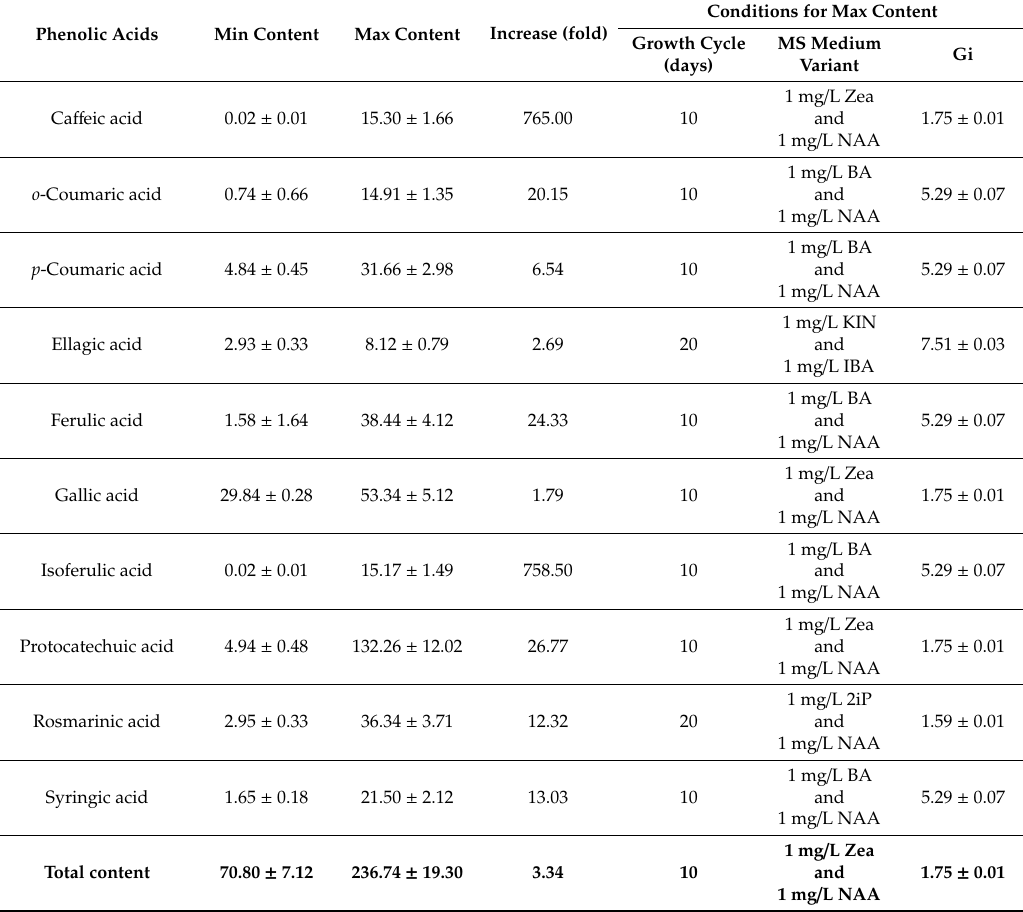
Table 3. The range of individual and total phenolic acids contents (mg / 100 g DW ± SD) dependent on duration of growth periods and composition of cytokinins and auxins in the MS media variants in agitated microshoot cultures. Values represent the mean ( ± SD) of five samples ( n = 5). Table is corresponding with Table